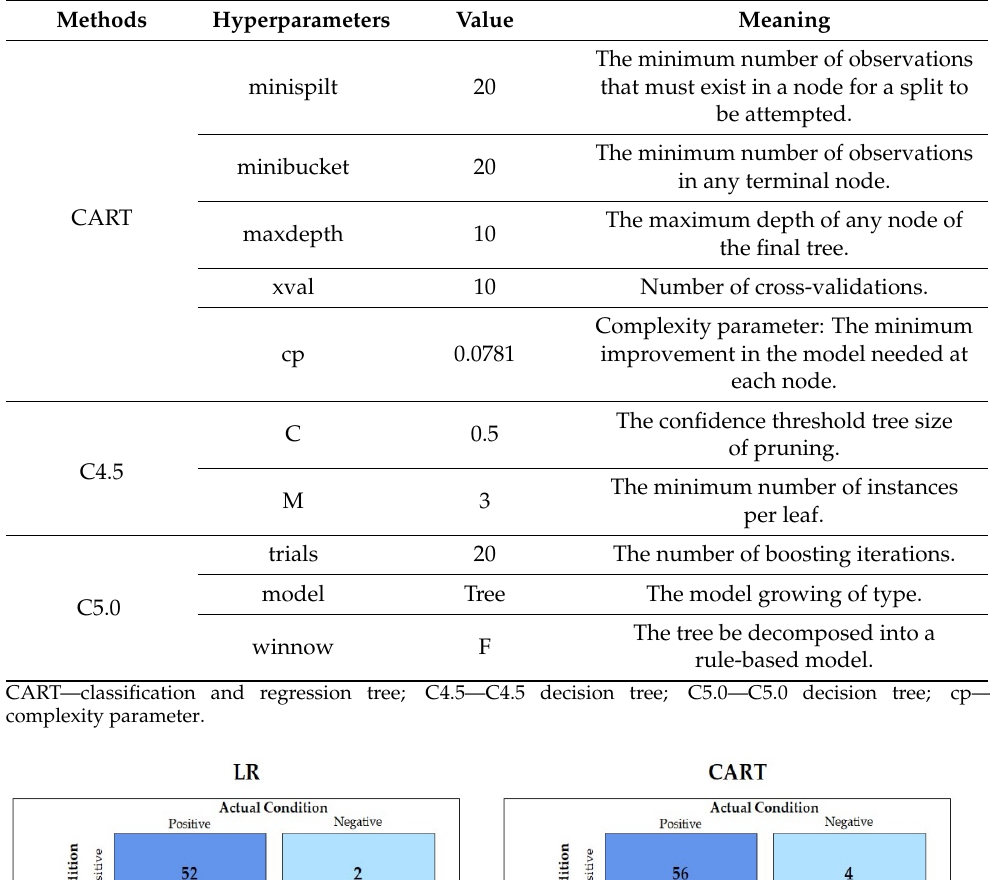
Table 3. Summary of the values of the hyperparameters for the best CART, C4.5, and C5.0 models.